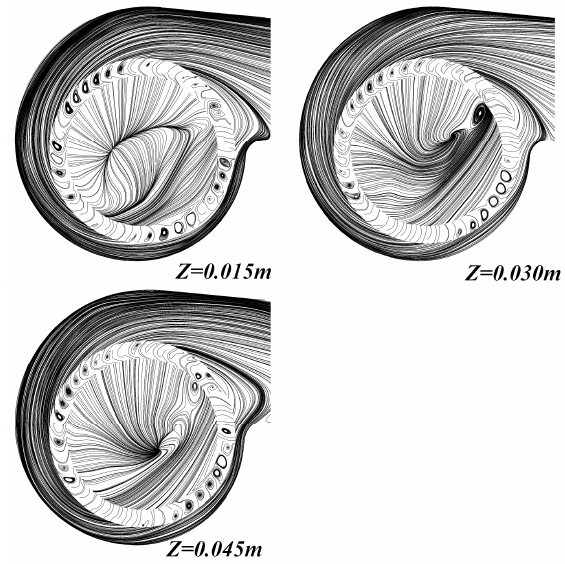
ff erent positions (Q / Qn = Figure 12. Streamline of cross-sections at different positions (Q/Qn = 1). Figure 12. Streamline of cross-sections at different positions (Q/Qn = 1). Figure 12. Streamline of cross-sections at di